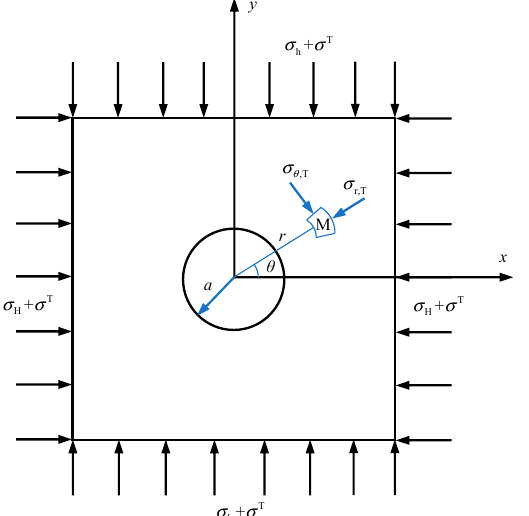
Figure 3. The mechanical model of hydraulic fracturing stress measurements in a high geo-temperature environment.